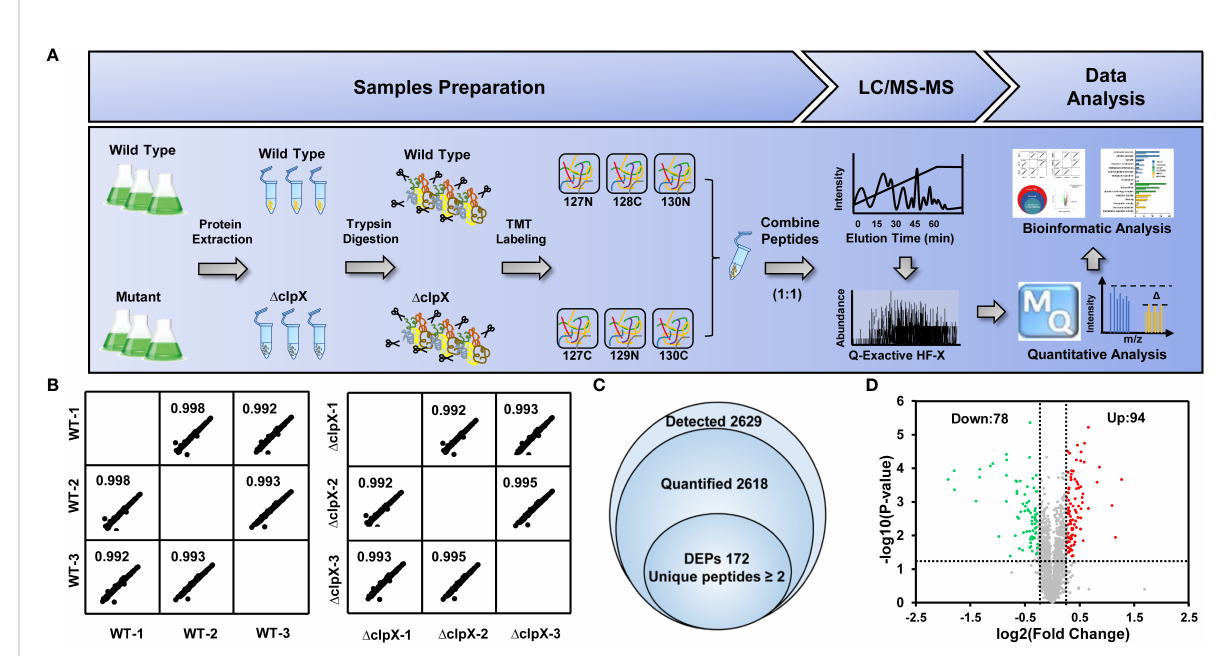
FIGURE 3 Work fl ow and quantitative proteomics data. (A) Work fl ow for TMT labeling quantitative proteomic strategy. (B) Pairwise correlation of peak area of identi fi ed proteins between three biological replicates. (C) Venn diagram showing the overlap of the number of detected proteins quanti fi ed proteins, and differentially expressed proteins (DEPs). (D) Volcano plots showing p -values ( – log 10 ) versus the fold change (log 2 ) of DEPs. Proteins with p < 0.05 and fold change > 1.2 or < 0.83 are considered to be differentially expressed. Upregulated and downregulated proteins are marked as red and green dots, respectively.